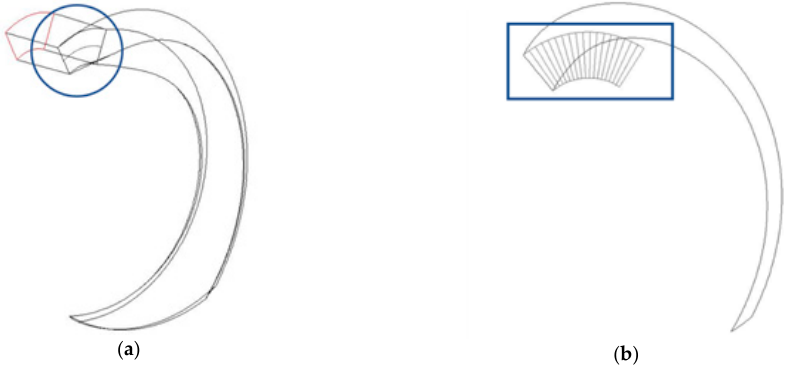
Figure 6. View of the arc ( a ) and the iso-clips ( b ) where the pressure and the velocity were evaluated. Figure 7 points out that the higher the number of blades, the lower the pressure difference